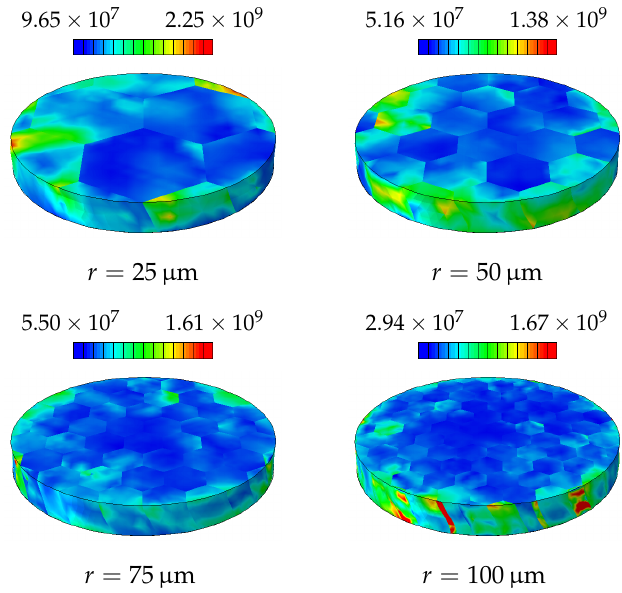
Figure 7. Final distribution of GNDs [ mm − 2 ] in the disc as a result of the applied